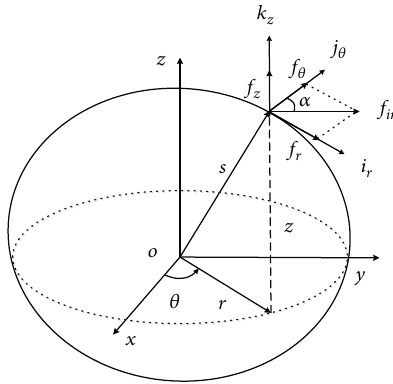
Figure 1: Diagram of the inertial and local cylindrical coordinate systems.